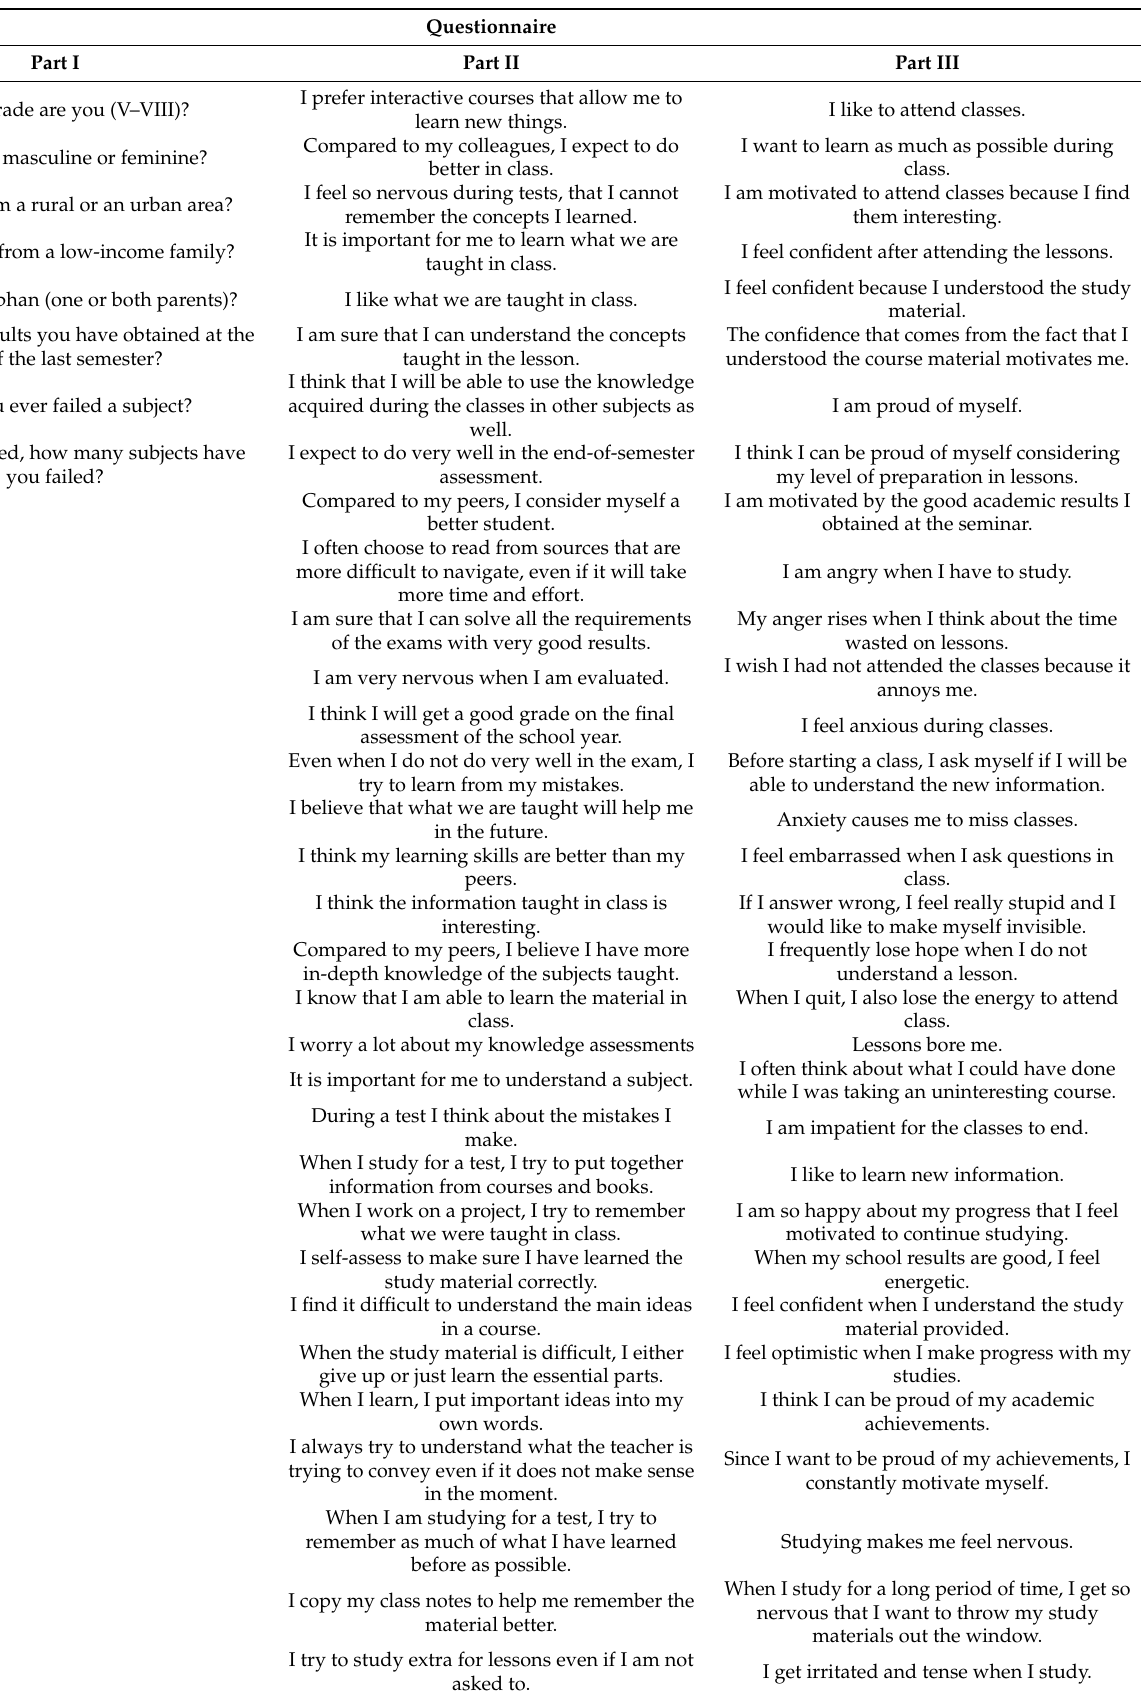
Table 1. The questionnaire